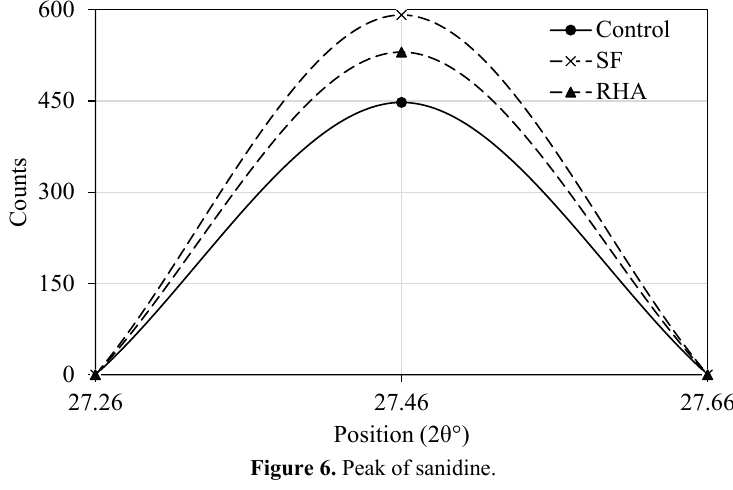
Figure 6. Peak of sanidine.